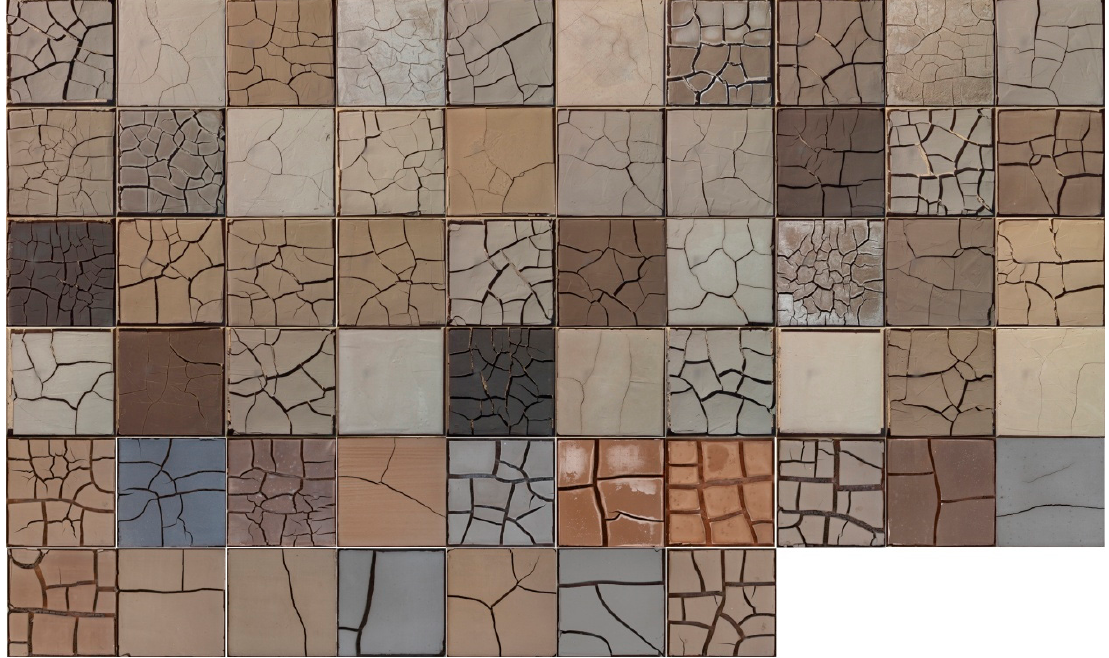
Figure 2. Cracked soil samples after drying process.